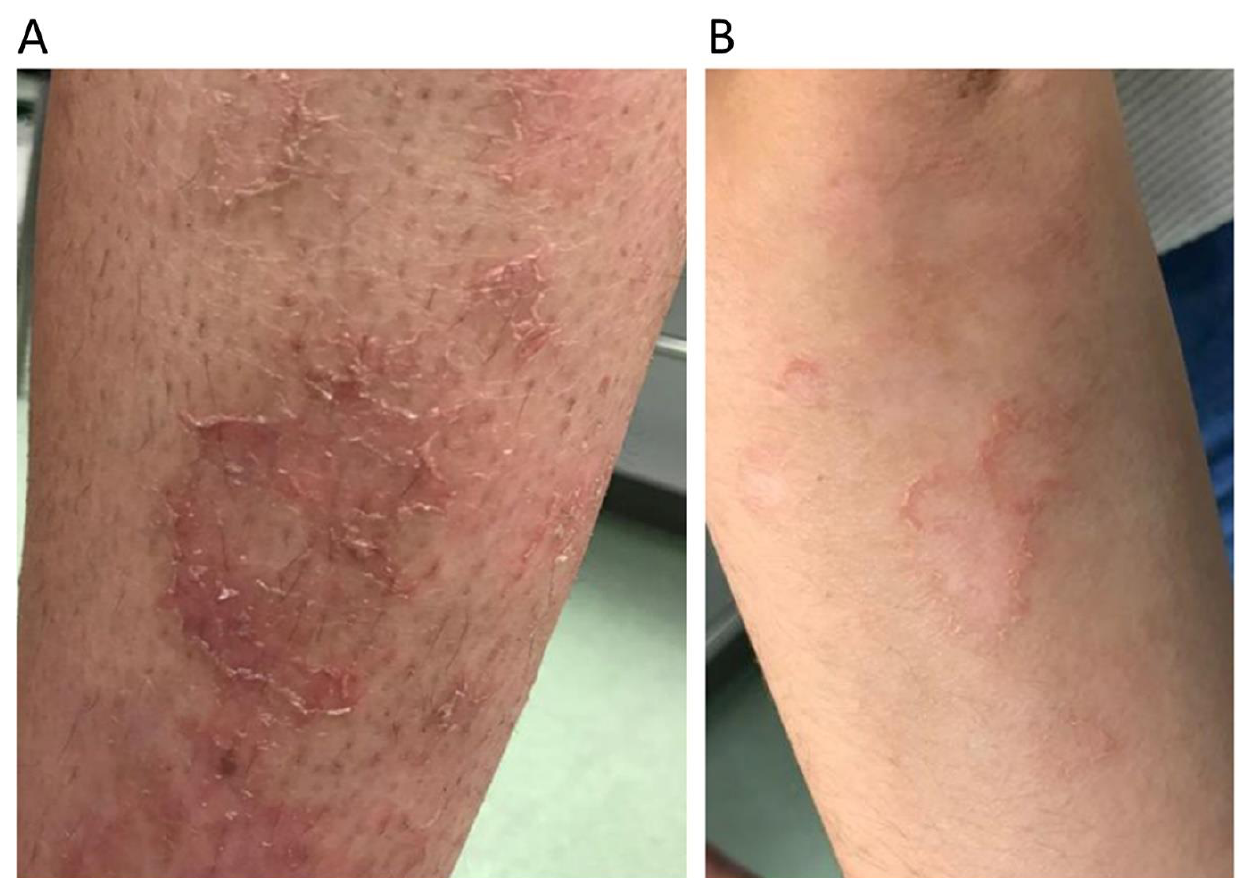
Figure 1. Psoriasis-like skin lesions in patient from Family 1 in lower (Panel A ) and upper (Panel B ) extremities.